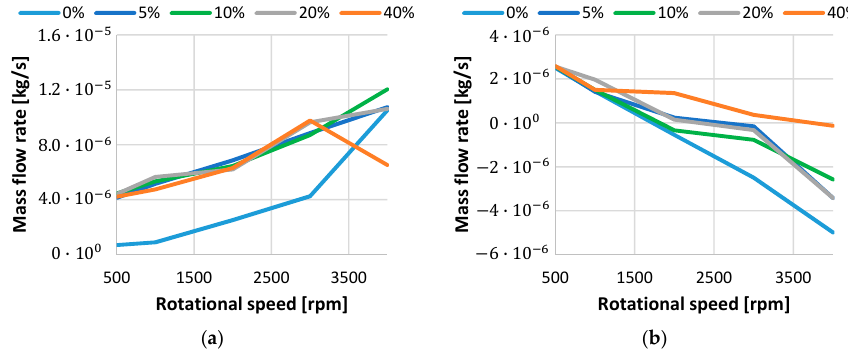
Figure 26. Leakage mass flow rates in ( a ) radial gap 1 and ( b ) radial gap 2 for different IGVF of free air and rotational speeds at 5-bar delivery pressure.